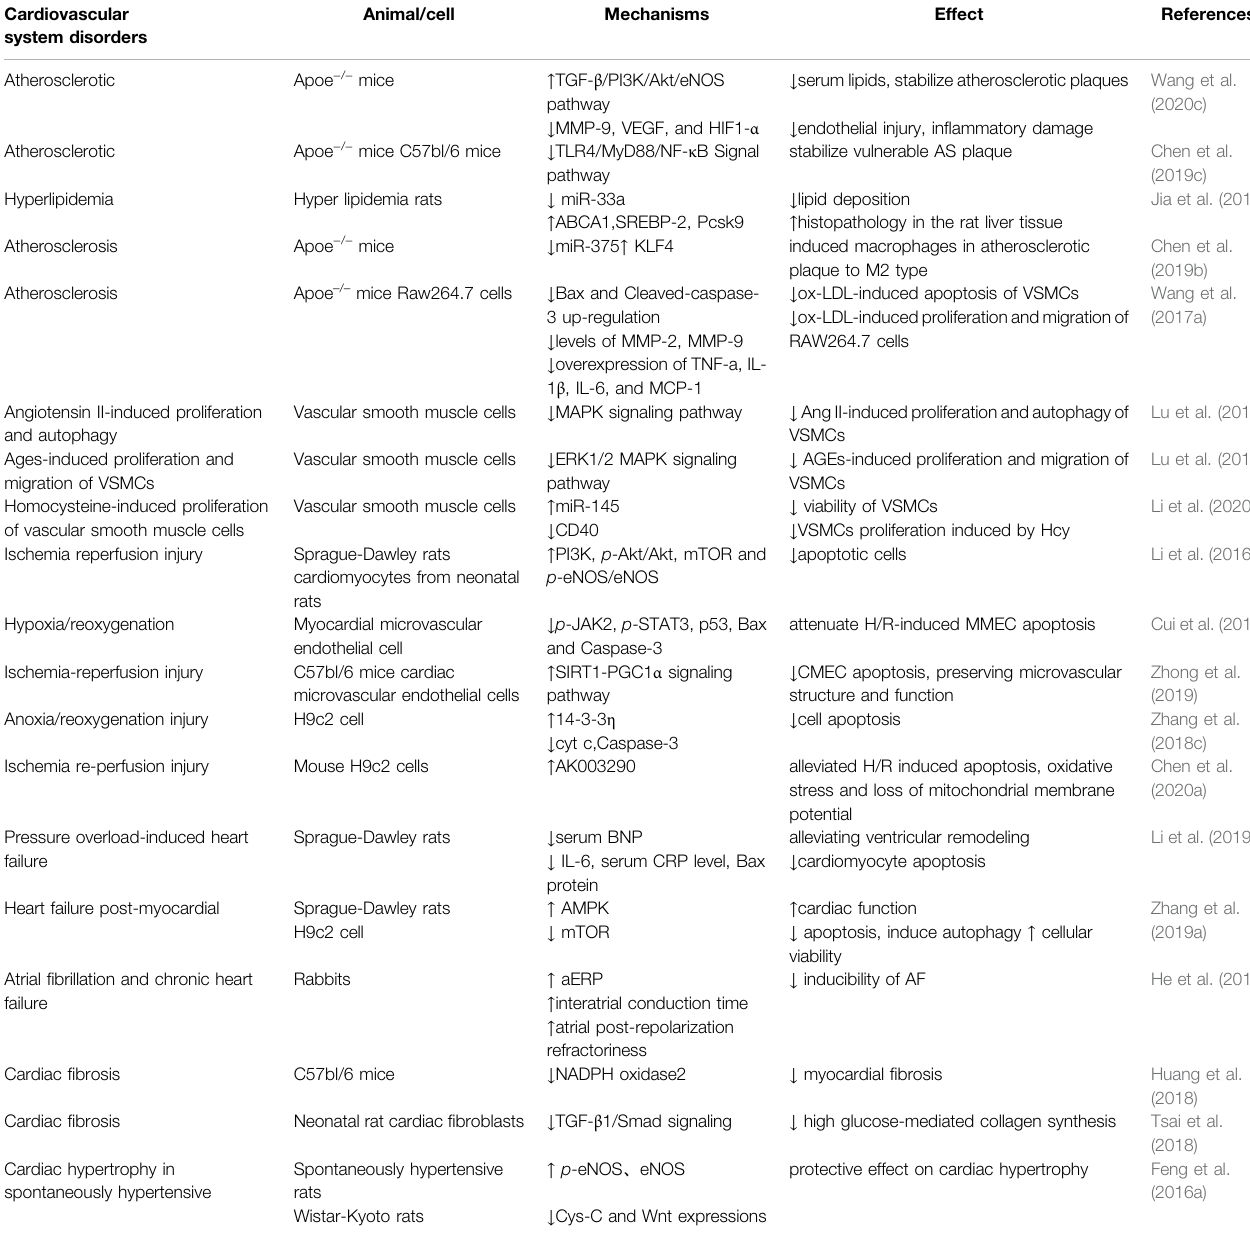
TABLE 2 | Summary of the therapeutic effects and mechanisms of Tan IIA on cardiovascular system disorders. Cardiovascular system